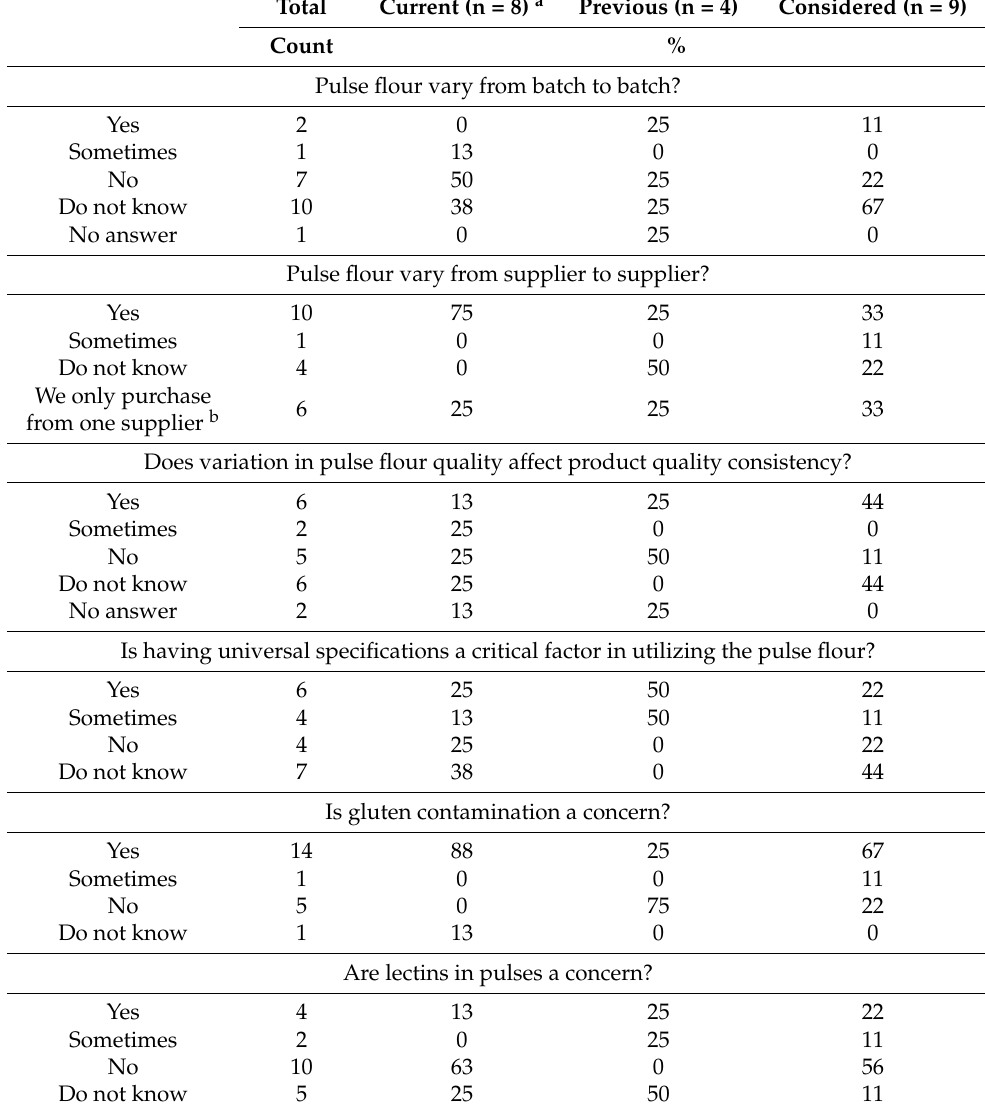
Table 11. The CPC users’ opinions on pulse flour quality variability, universal specification, gluten contamination, and